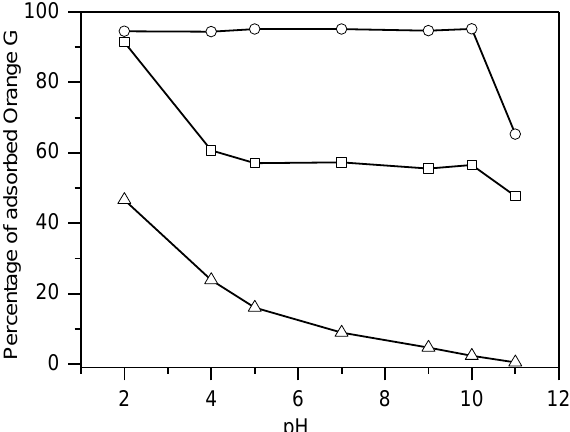
Figure 10. Effect of pH on the percentage of adsorbed OG dye on (ο) B -Act- CTAB300, (□) B -CTAB and (Δ) B -Act-CTAB100 samples (experimental conditions: C o = 50 mg/L; m s = 1 g/L; contact time t = 60 min; T = 298 ± 1 K).